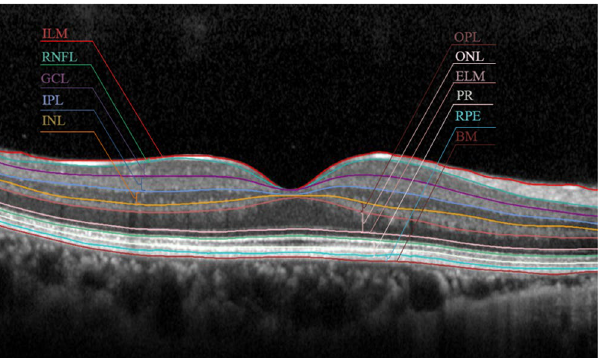
Figure 2. A representative figure of retinal layer division determined by the automated segmentation application of the Spectralis optical coherence tomography (OCT). The segmentation software automatically marked the 10 retinal layers (ILM = inner limiting membrane; RNFL = retinal nerve fiber layer; GCL = ganglion cell layer; IPL = inner plexiform layer; INL = inner nuclear layer; OPL = outer plexiform layer; ONL = outer nuclear layer; ELM = external limiting membrane; PR = photoreceptors; RPE = retinal pigment epithelium; BM = Bruch’s membrane).